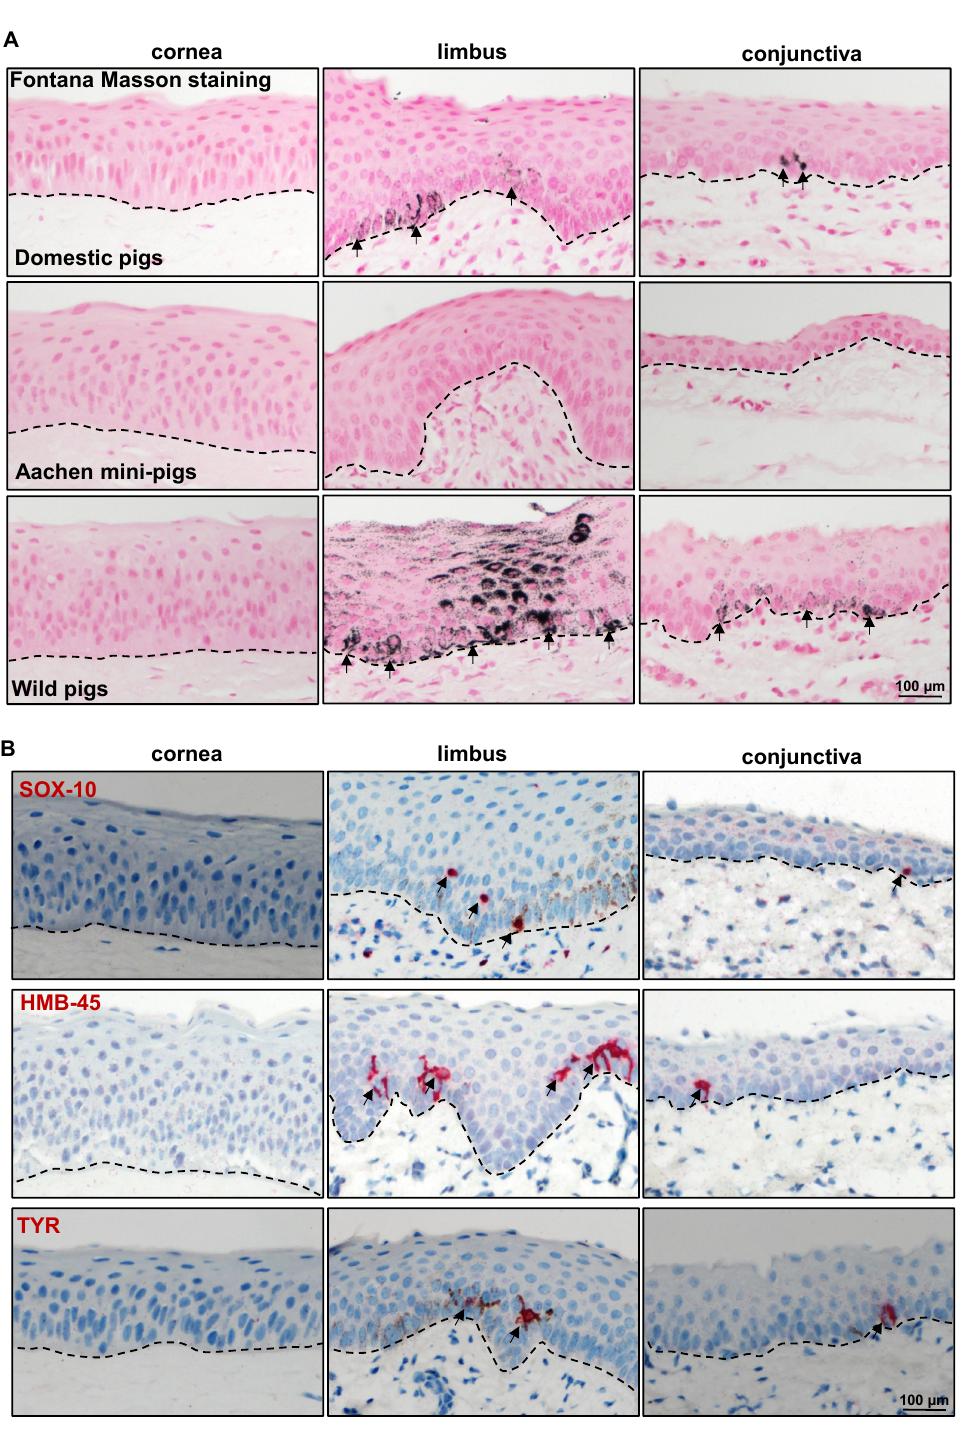
Figure 7. Expression analysis of melanocyte-related markers: ( A ) Light micrographs of paraffin sections of corneoconjunctival specimen stained with Fontana-Masson showing the melanin in the limbal and conjunctival regions of domestic porcine samples and wild pigs (arrows), whereas there was no melanin in the Aachen minipig samples; dashed line represents the basement membrane (BM). ( B ) Immunohistochemical staining corneoconjunctival sections showing the SRY-homeobox10(SOX- 10) + , human melanoma black(HMB-45) + , and tyrosinase (TYR) + cells in the basal layers of limbal and conjunctival epithelium; dashed line represents BM.